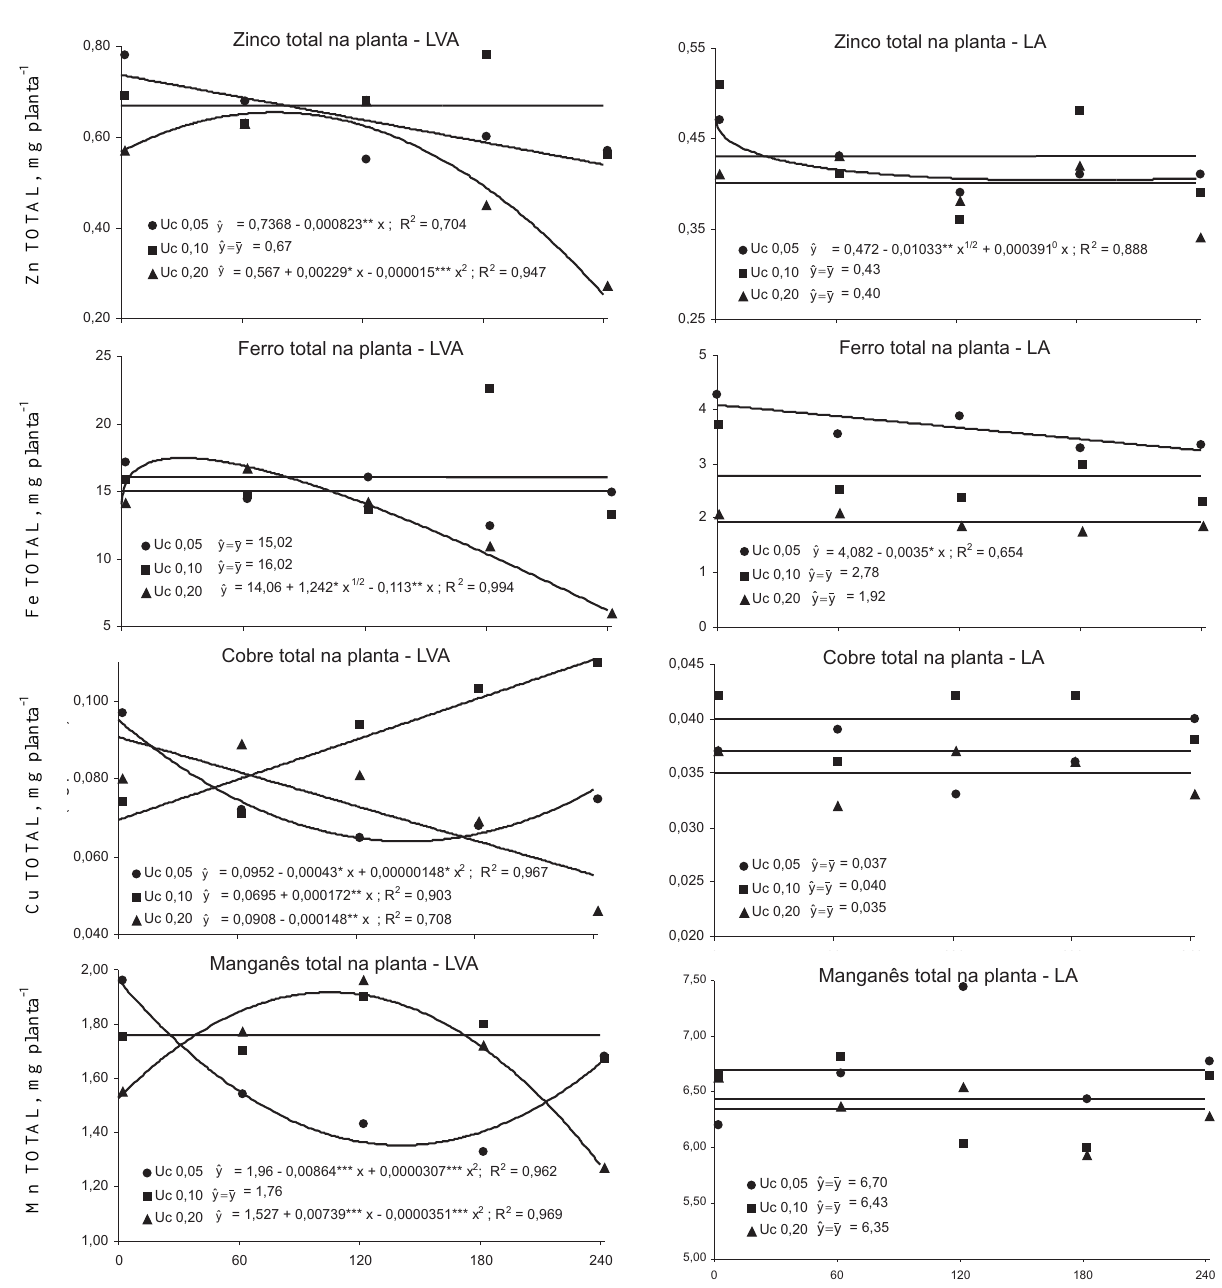
Figura 5. Conteúdos de zinco, ferro, cobre e manganês na matéria seca total de eucalipto em dois Latossolos compactados com diferentes pressões e